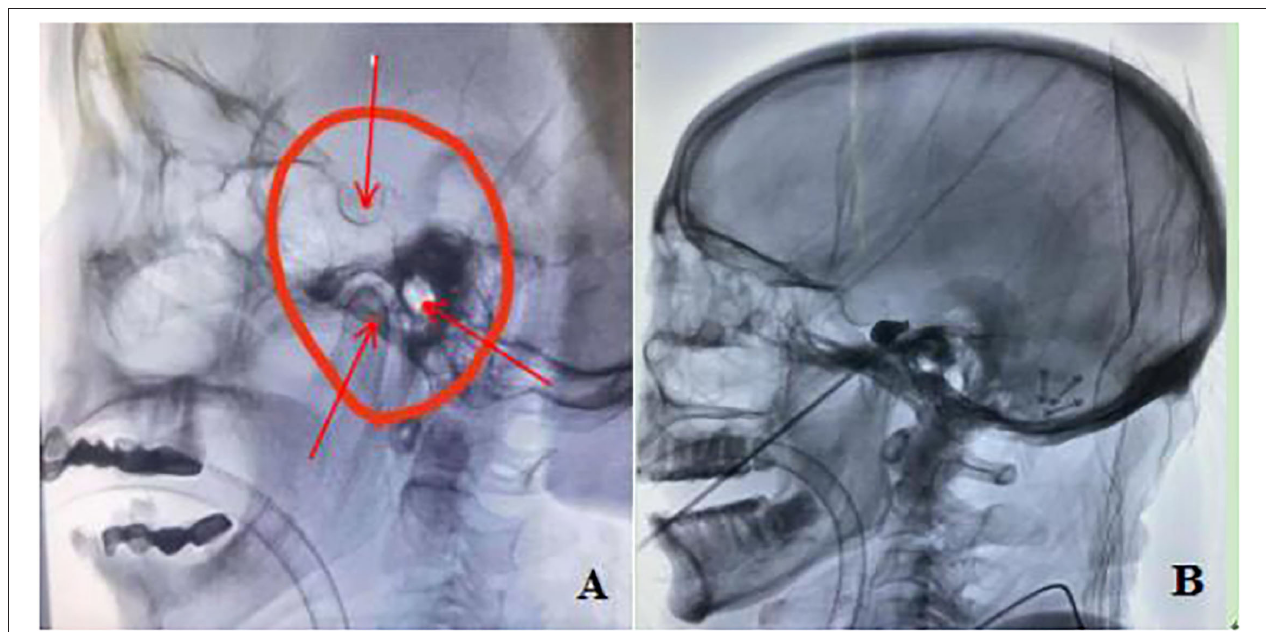
FIGURE 3 | (A) When the posterior margin of the upper palate, temporomandibular joint and external auditory canal overlap (shown by arrow), it was considered a standard lateral position; (B) After the puncture needle pierces the dura mater of foramen ovale, it needs to be kept outside the skull to avoid further penetration, and the balloon will form an “inverted pear” shape after